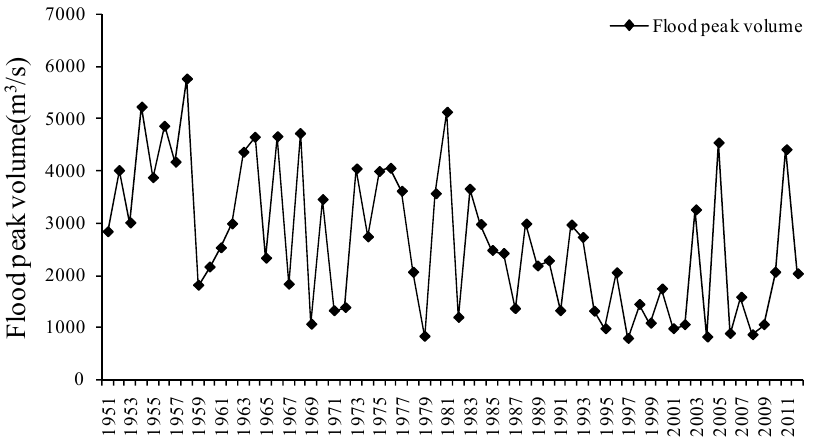
Figure 4. Annual flood peak volume of Huaxian County from 1951 to 2012.